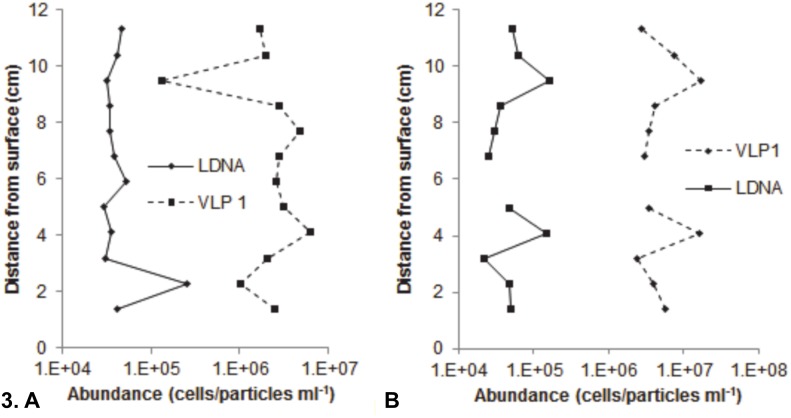
Single vertical profile of VLP 1 and LDNA populations at Noarlunga.
A Microplate three showing little to no association. B Microplate one showing association. Gap in profile indicates a missing data point.